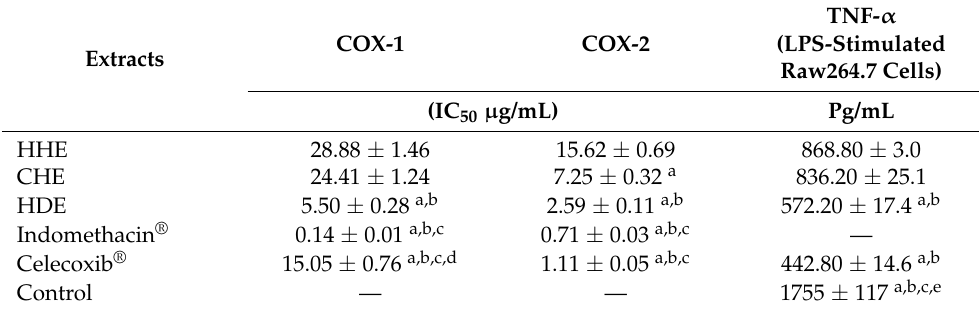
Table 3. Anti-inflammatory activity of the S. aegyptiaca essential oil